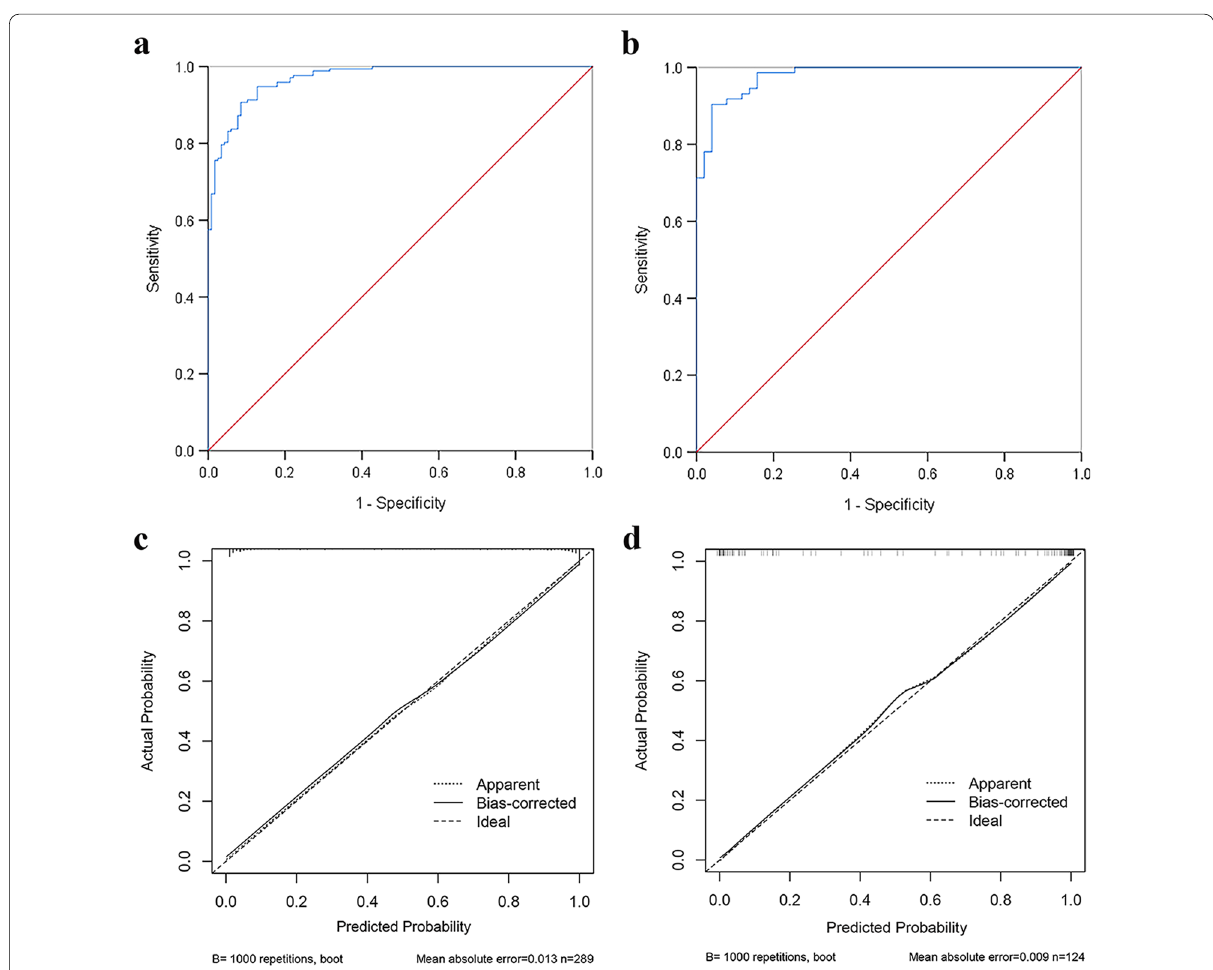
Fig. 3 ROC analysis of the predictive model in training ( a ) and test ( b ) cohorts, respectively, and calibration curves of the nomogram in the training ( c ) and test ( d ) cohorts,